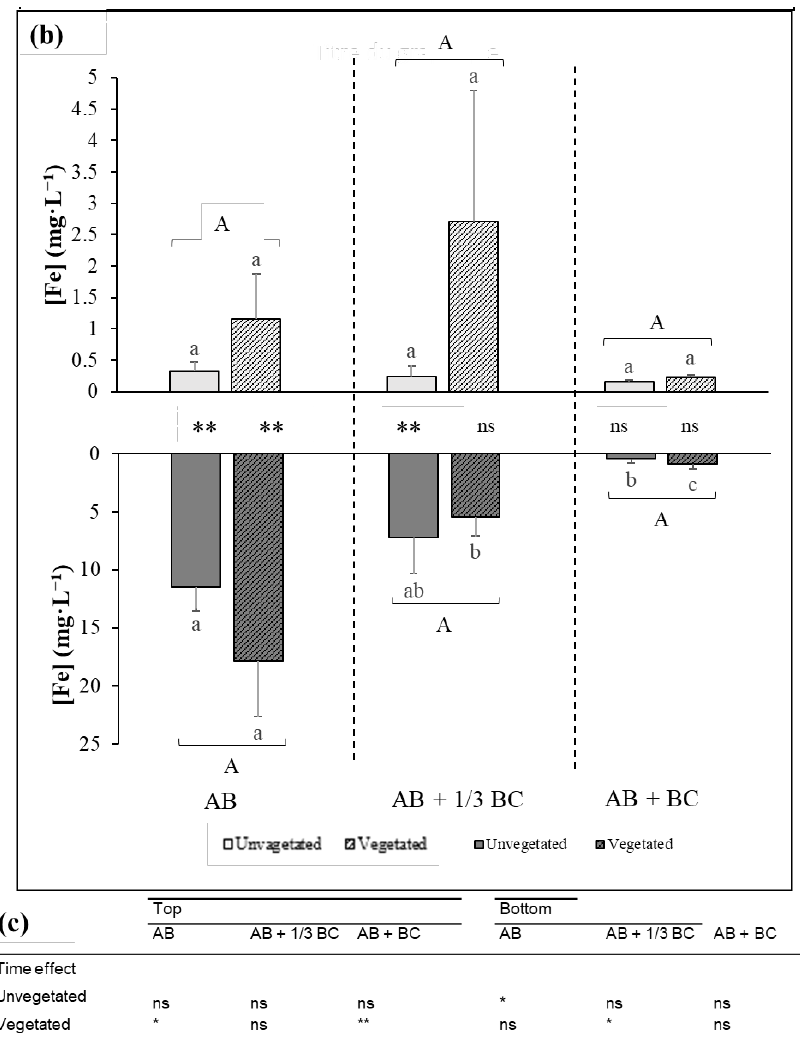
Figure 3. Soil pore water (SPW) iron concentration ([Fe] = mg·L −1 ) is mean of seven values (± SE), determined on Abbaretz (AB) technosol non amended or amended with 2% biochar added on the top 33 cm of the tube (AB + 1/3 BC) or on the tube entirety (AB + BC) in the unvegetated tubes and in the tubes vegetated with Alnus sp. SPWs were sampled both at the top (light gray box) and at the bottom (gray box) of the tubes, in ( a ) October 2019 (T7) and in ( b ) October 2020 (T19). The treatment effect in the vegetated and unvegetated conditions (taken separately, the level effect for each treatment/(un)vegetated condition and the ( c ) time effect between T7 and T9 are given with level of significance: ns = non-significant ( p ≥ 0.05); * ( p ≤ 0.05); ** ( p ≤ 0.01); *** ( p ≤ 0.001).